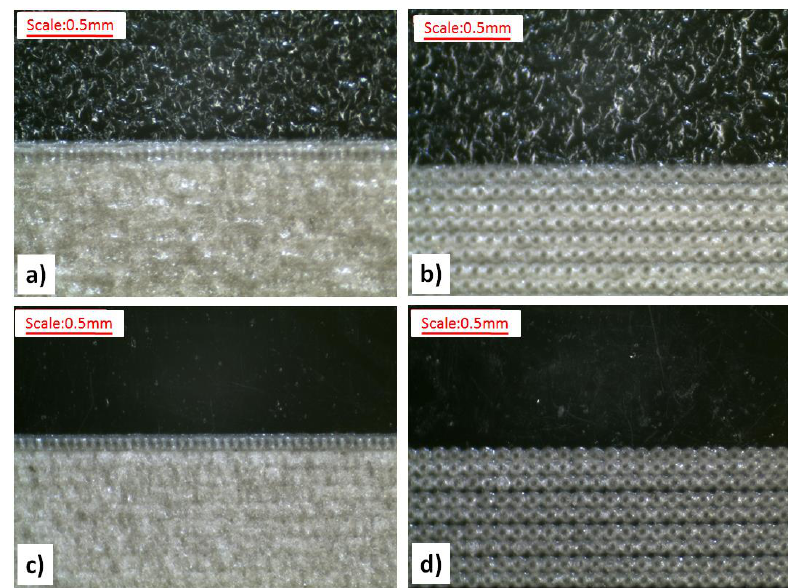
Figure 5. The influence of laser marking velocity on the exemplary surfaces of samples without LMA: ( a ) DA surface, B laser head velocity (750 mm · s − 1 ); ( b ) DA surface, D laser head velocity (1350 mm · s − 1 ); ( c ) P surface, B laser head velocity; and ( d ) P surface, D laser head velocity.